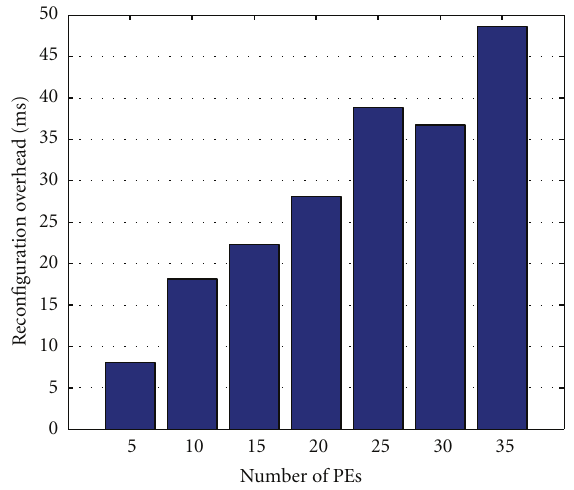
Figure 10: Specialization overhead (ms) needed to reconfigure the PEs of the RTR aligner one time, based on measurements in the test